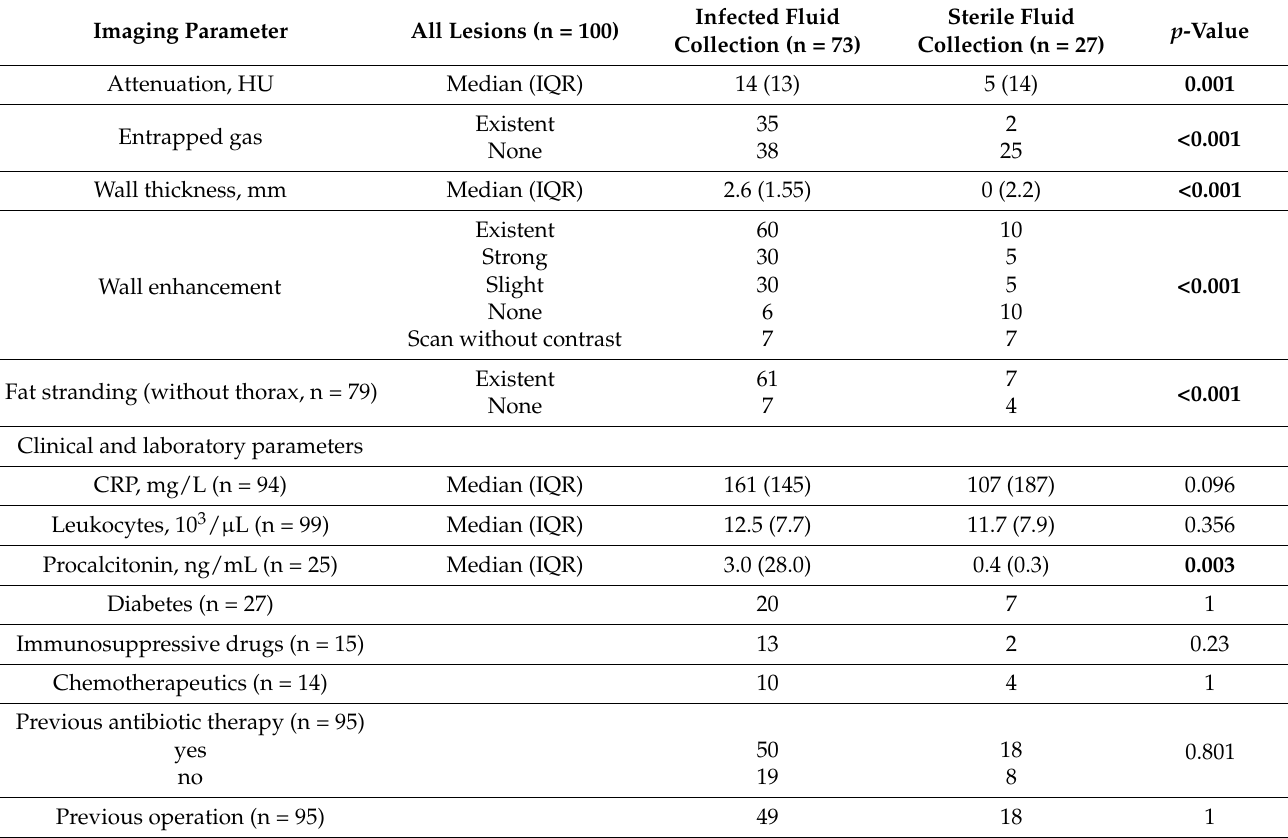
Table 2. CT imaging findings, laboratory results, and clinical data of patients with fluid